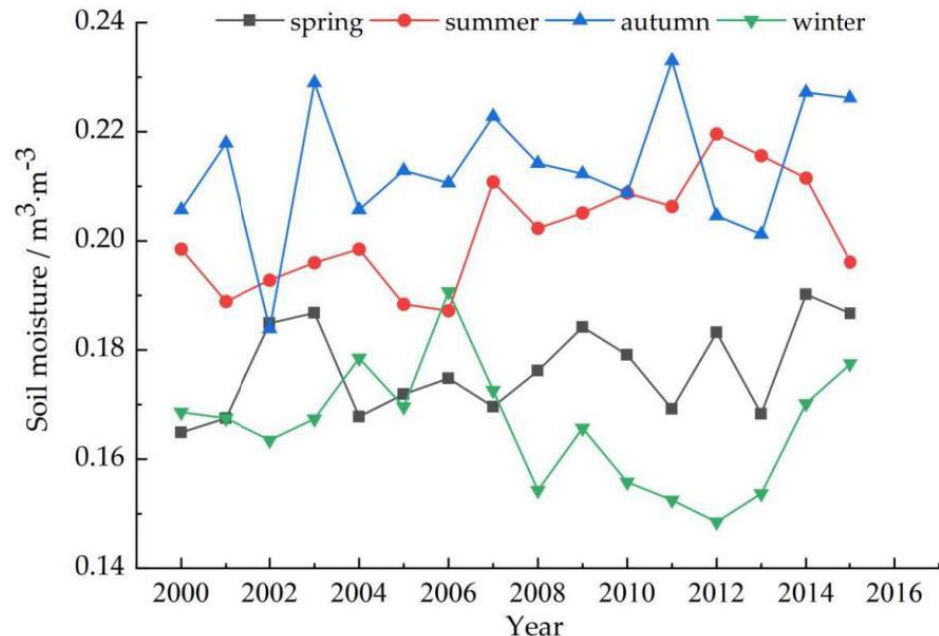
Figure 8. The SM variation curve of the four seasons in the YRB from 2000 to 2015.